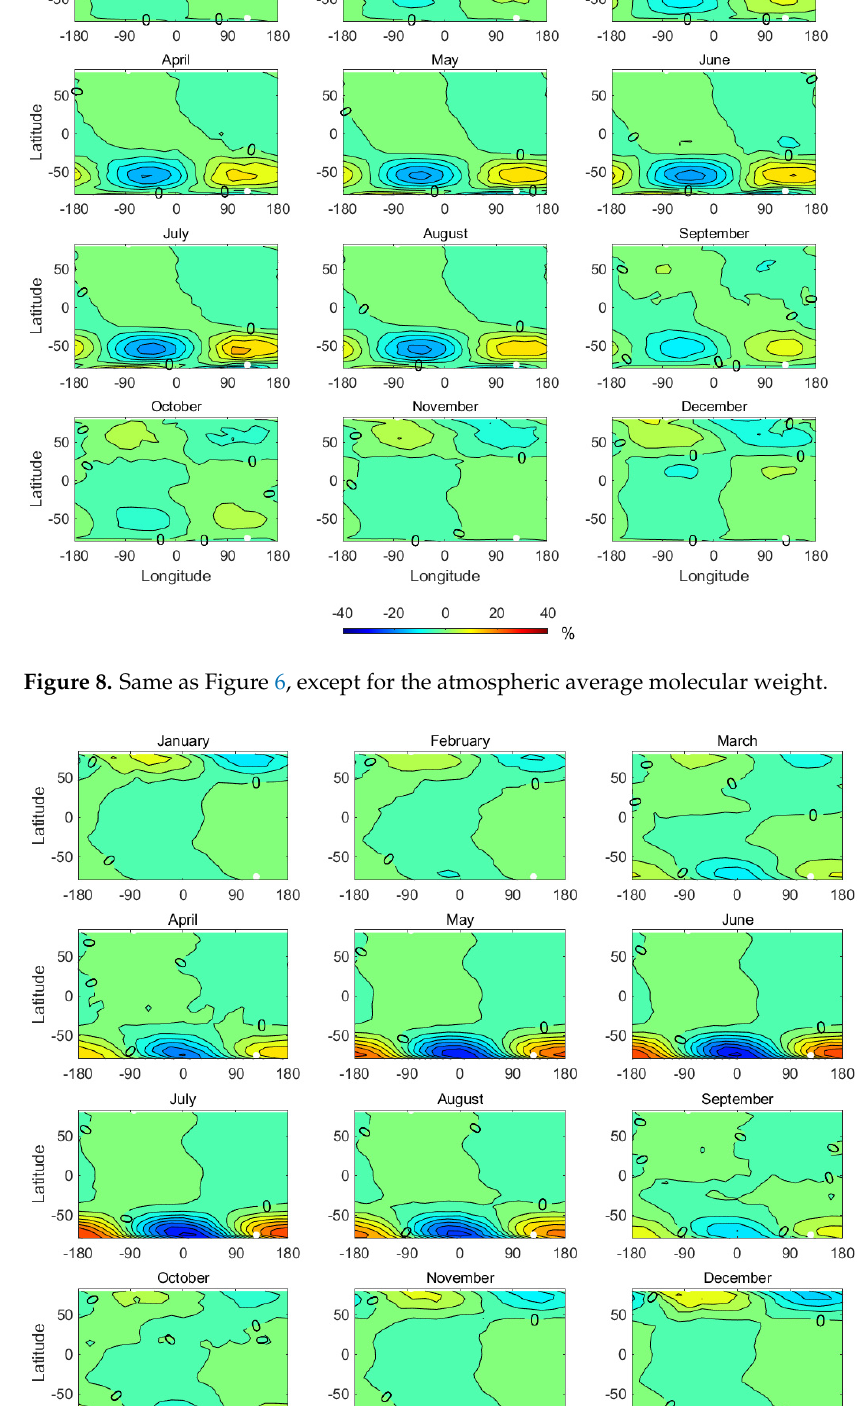
Figure 9. Same as Figure 7, except for the atmospheric average molecular weight.